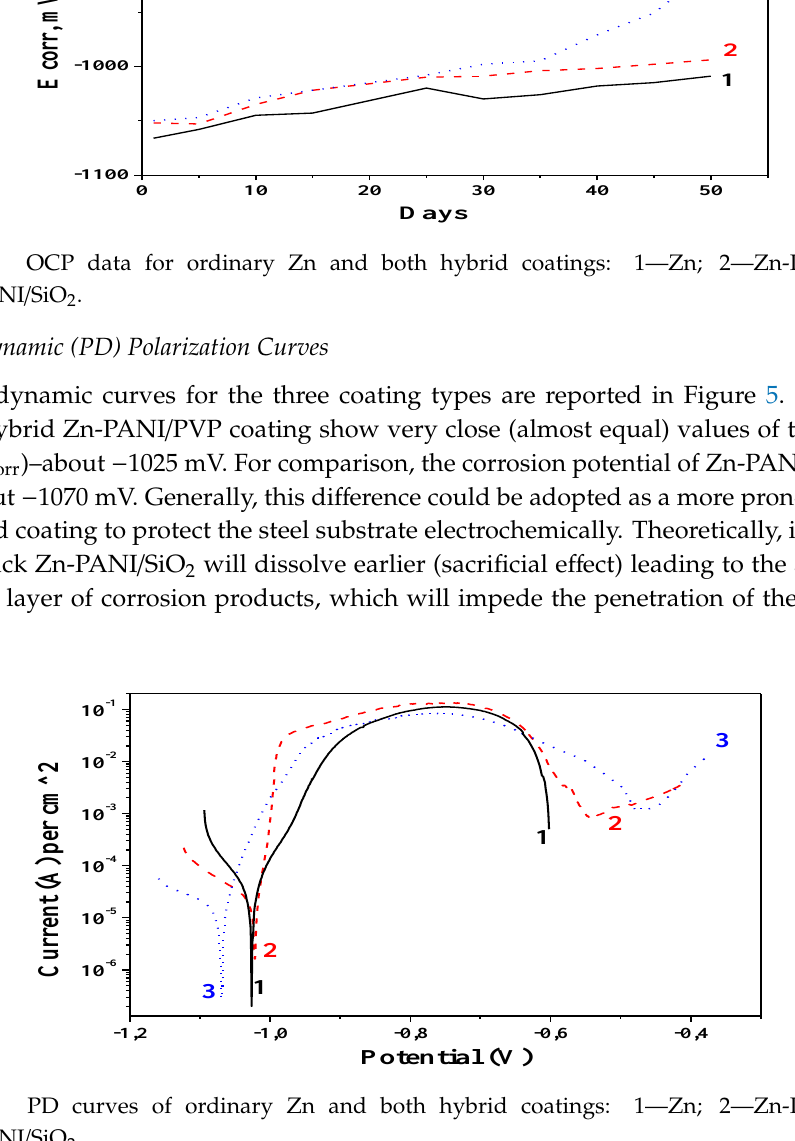
presented in Figure 3. It could be summarized that OCP values of both hybrid coatings are more